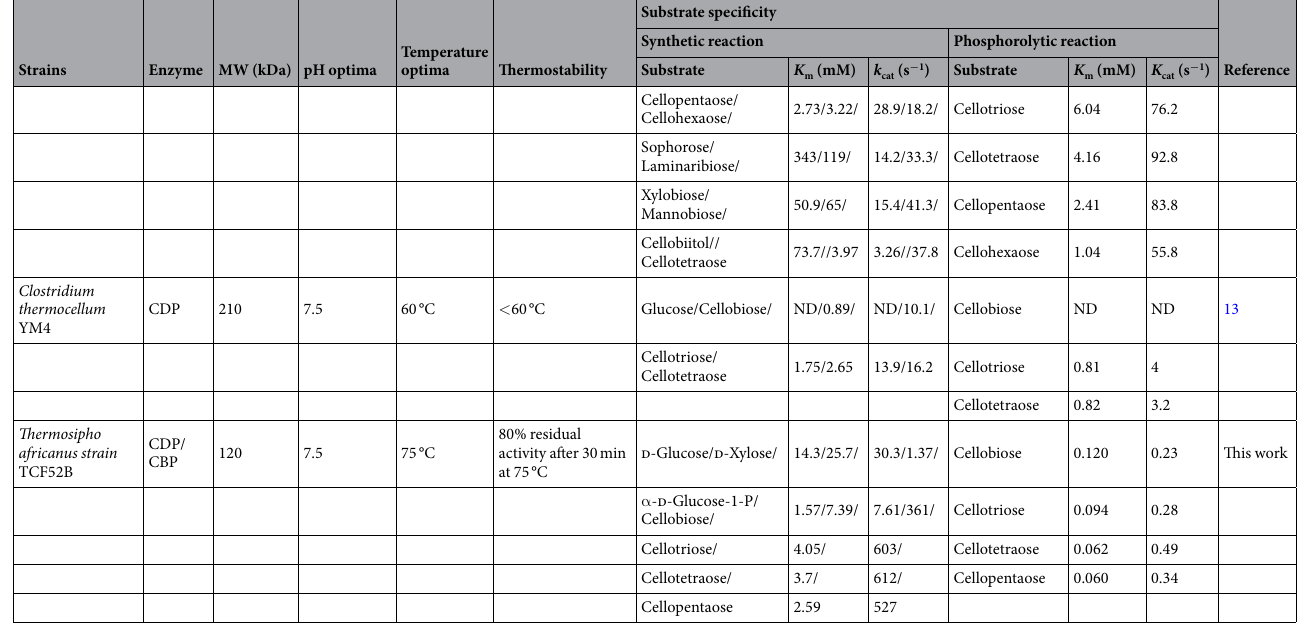
Table 5. Properties of chararcterized CBPs and CDPs from different strains. “ − ”: not tested; ND: not